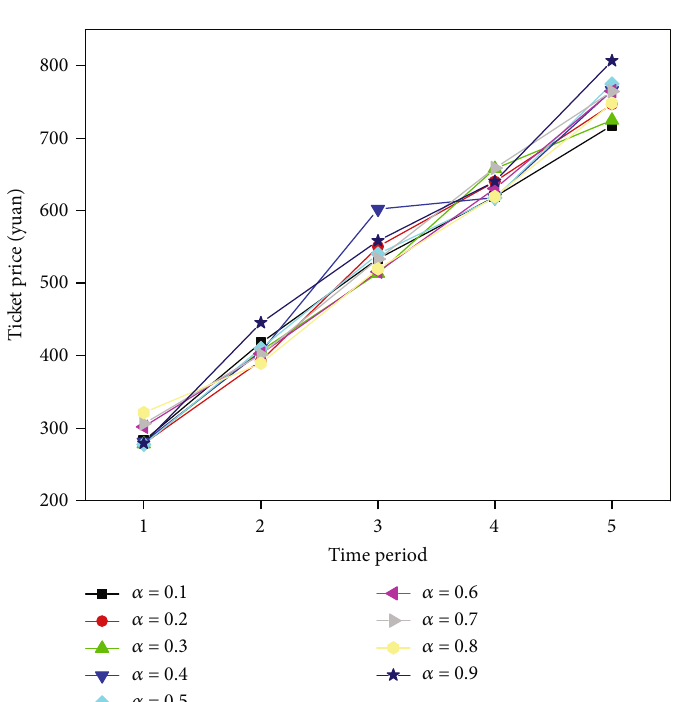
Figure 10: Ticket price of train A in OD